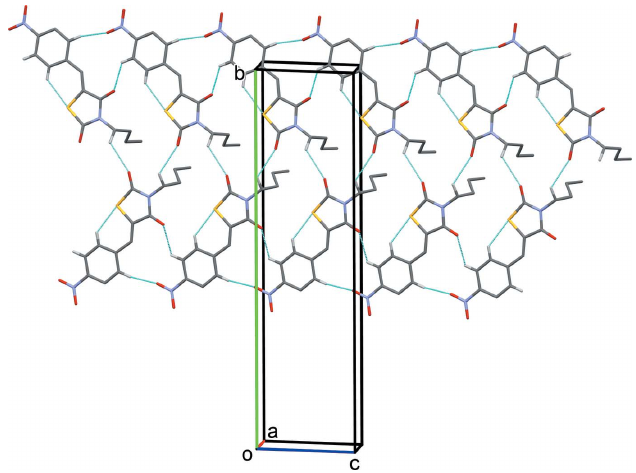
Figure 2 A partial view along the a axis of the crystal packing of the title compound. Dashed lines indicate hydrogen bonds (Table 1) and H atoms not involved in these interactions have been omitted.